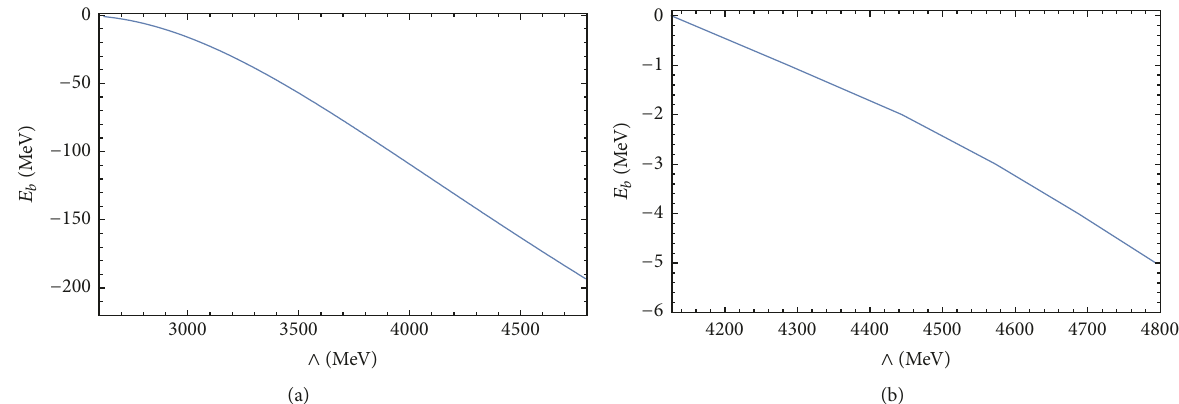
strictly considering this criterion of the value of Λ , we conclude that there does not exist isovector 𝐵𝐾 molecular state. And the 𝑋(5568) cannot be the 𝐵𝐾 molecular state. The relations between Λ and 𝐸 푏 for the 𝐵𝐾 with 𝐼 = 0, 1 are depicted in Figures 1 and 2,